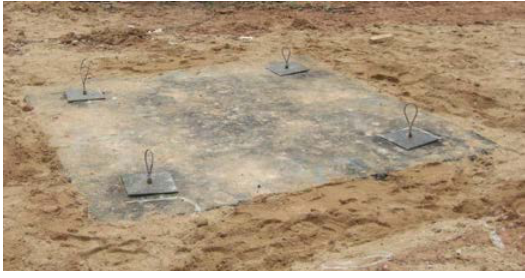
Figure 8. Plan view of the multi-layer pavement slab before the blast event.